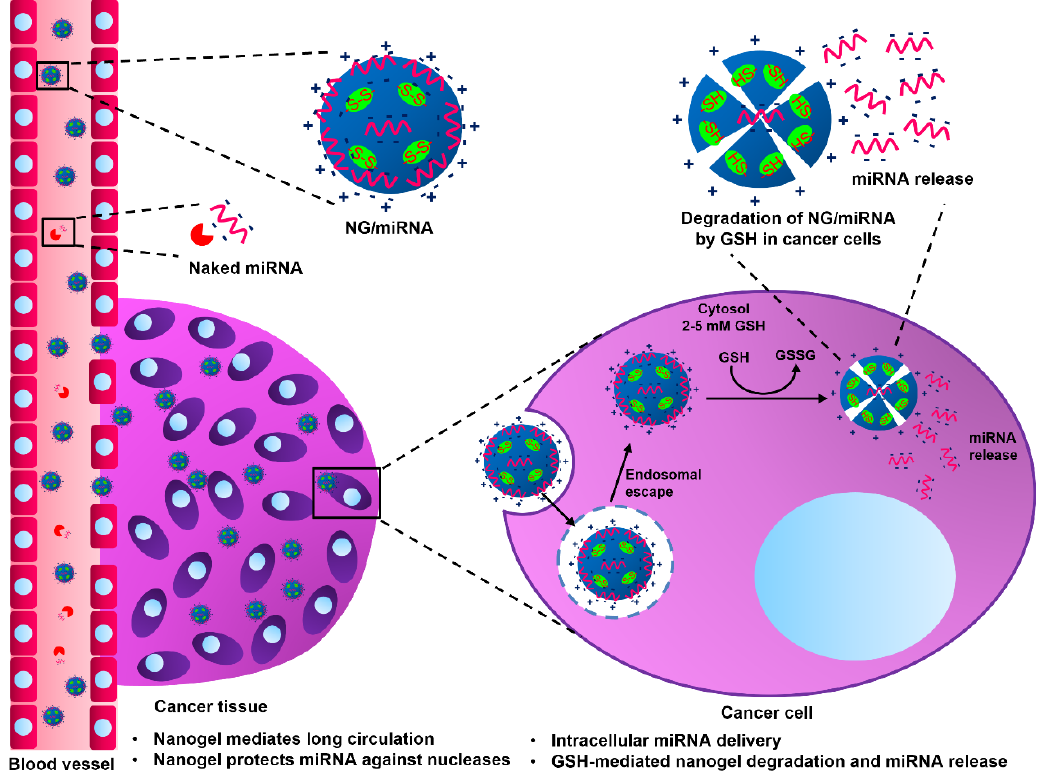
Figure 1. A schematic diagram of NG/miRNA in systemic circulation, miRNA protection against nucleases, enhanced permeability and retention (EPR)-mediated nanogel delivery to cancer tissue, cellular uptake, and intracellular miRNA release induced by GSH in cancer cells.